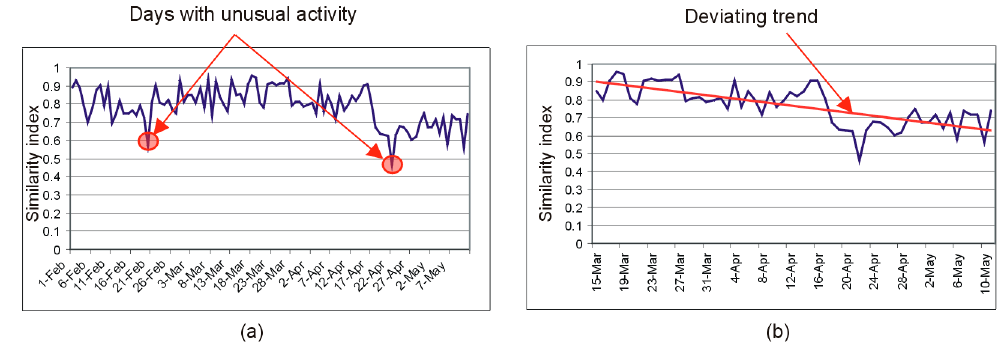
Figure 9. ( a ) Days with a low similarity index may indicate unusual activity. ( b ) Descending trends in the evolution of the similarity index may indicate deviations from the activity routine.